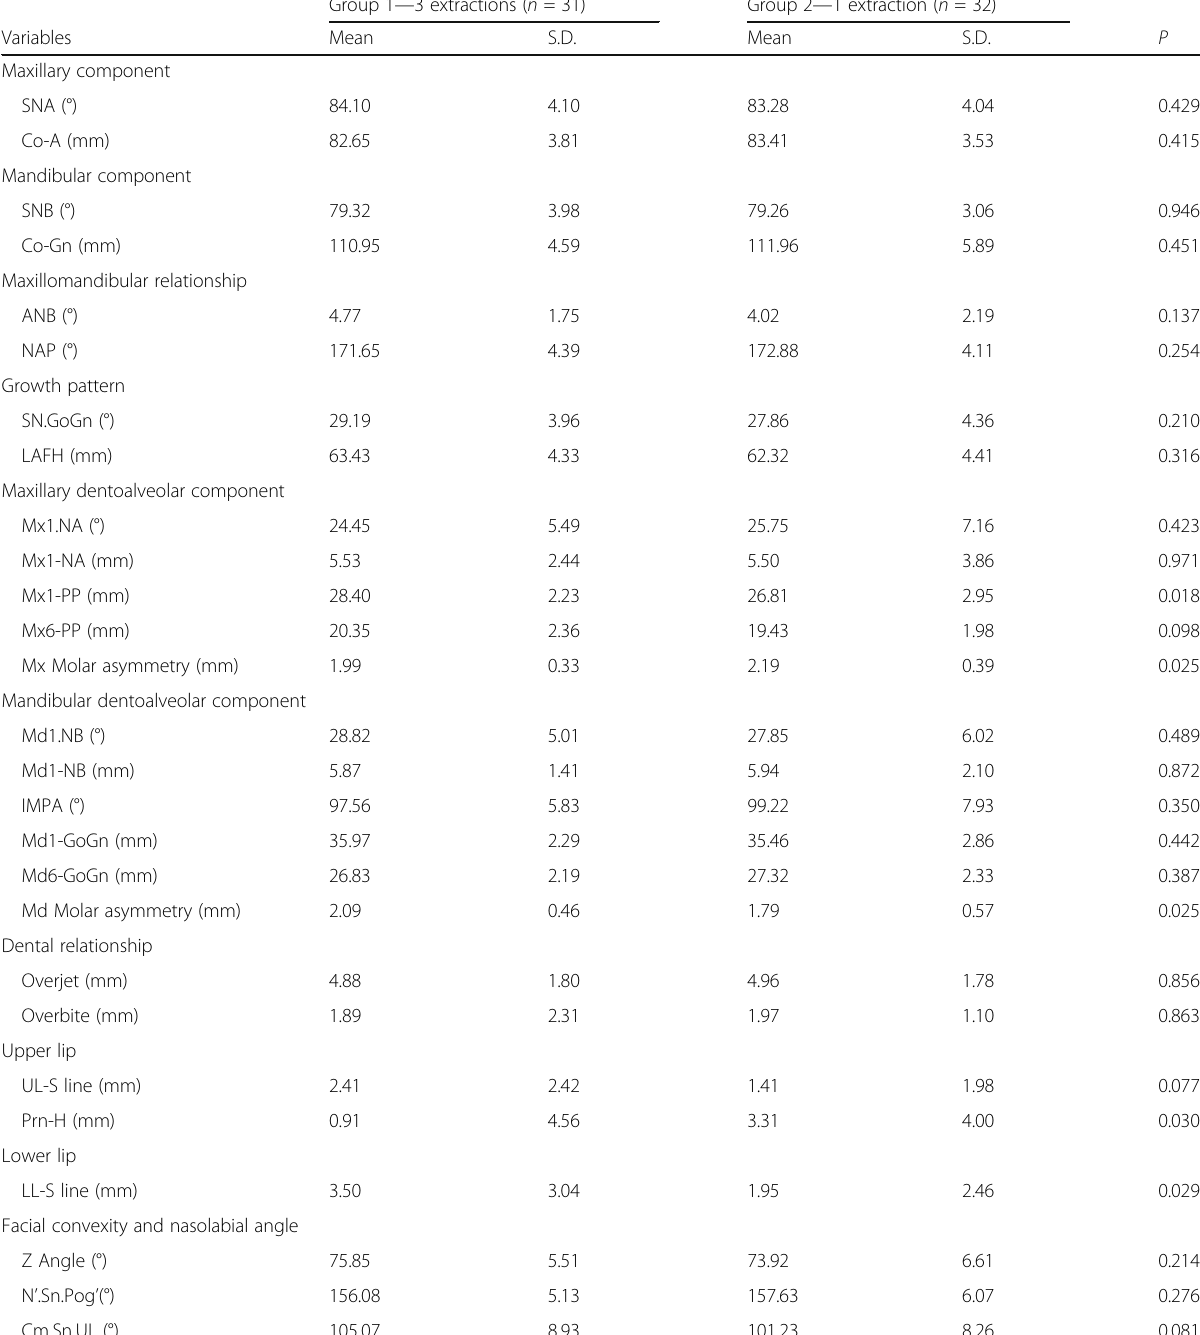
Table 3 Intergroup comparison at the pretreatment stage ( t tests) Group 1 — 3 extractions ( n =